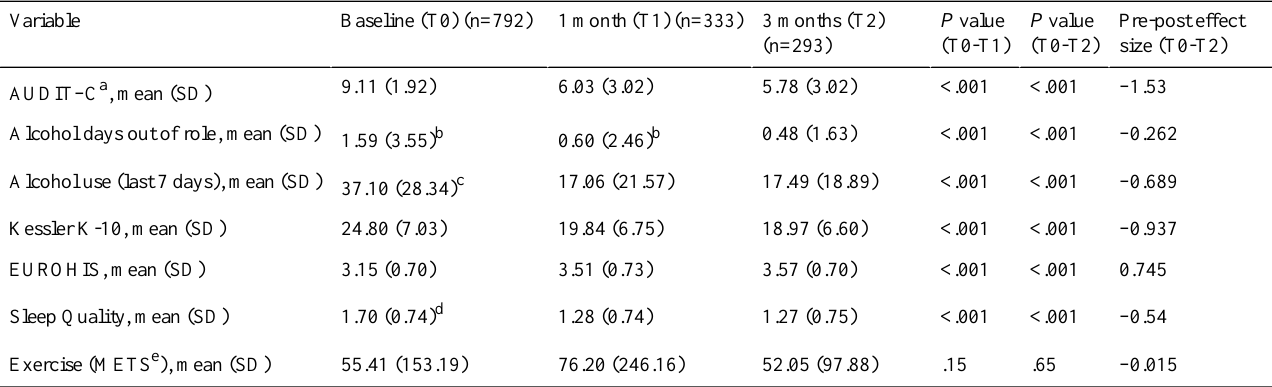
Table 3. Means and standard deviations for outcomes, with significance tests of changes from T0 to T1 and T1 to T2, plus effect size (T0-T2). Please note: not all participants responded to all items in the survey, resulting in missing